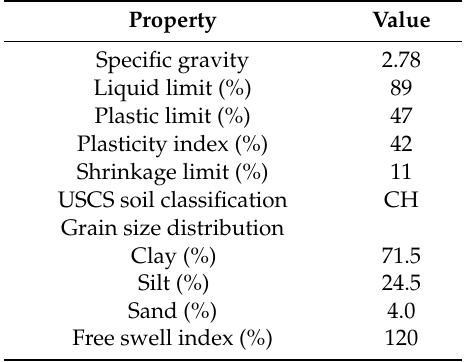
Table 1. Index properties of expansive soil considered.